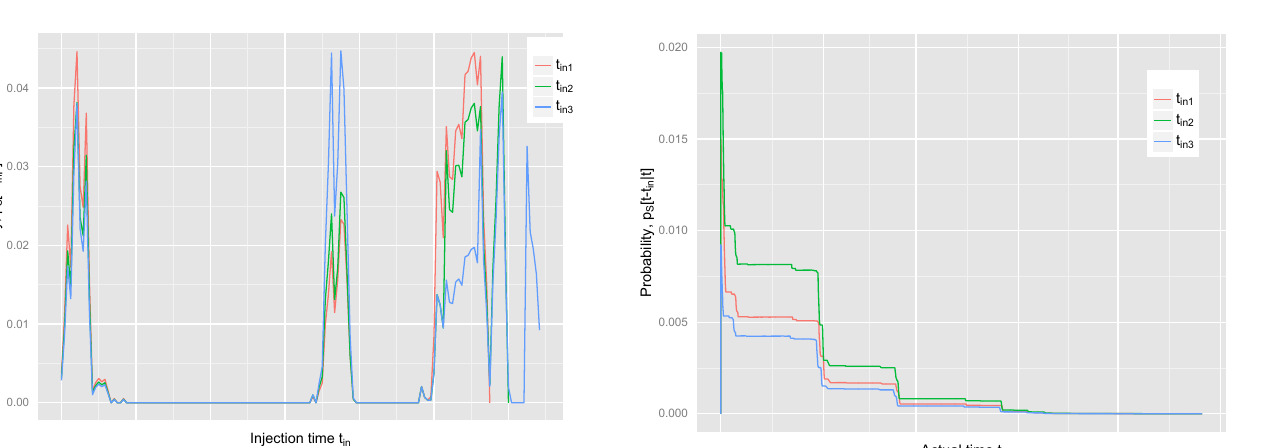
Figure 2. Representation of the evolution of the backward pdf for Figure 4. Representation of the evolution of the backward pdf , where i = 1, 3) as varying with the in- three injection times ( t in vs. the actual time t . The time shift between the three injections i jection time t in . The time shift between the three injections was was dropped for a direct comparison of the curves. In this case, the dropped for a direct comparison of the curves. area below the curves is not equal to